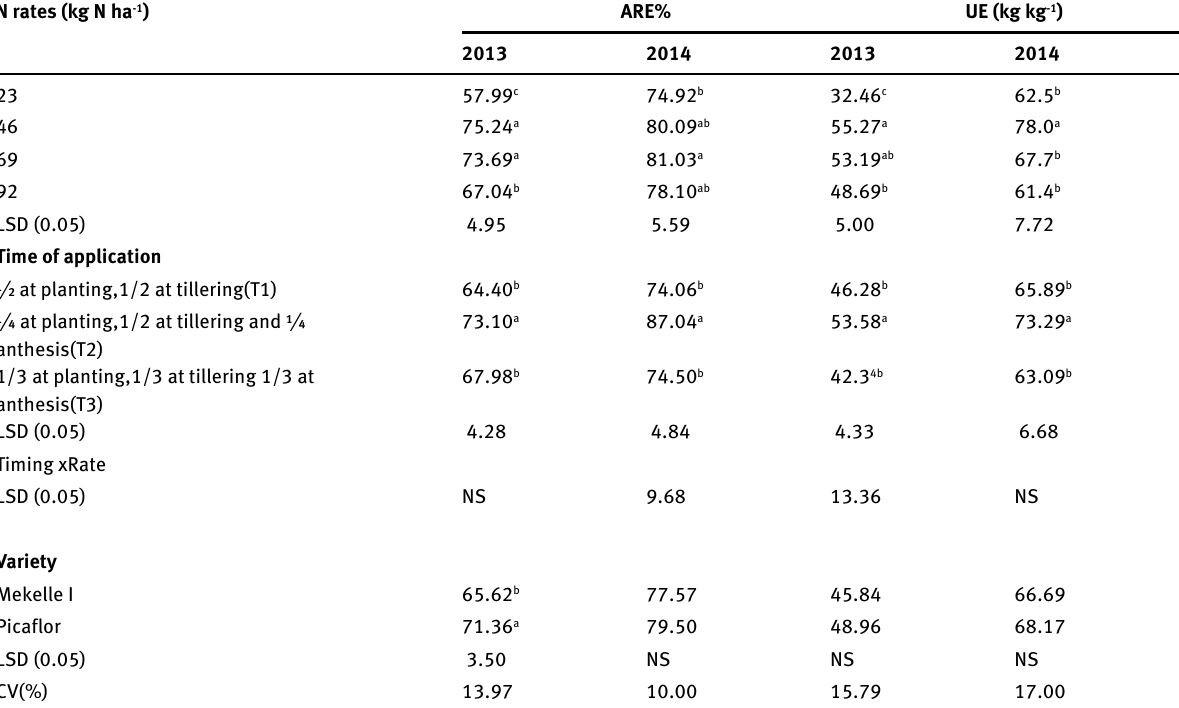
Table 3: Effect of N rate, timing and variety on apparent recovery, utilization efficiency of wheat in Enderta district, Tigray in 2013 and 2014 N rates (kg N ha -1